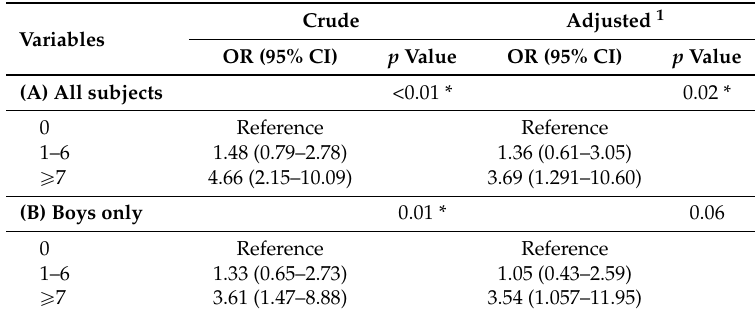
1 Adjusted covariates: gender, consumption of milk/meat/fruit/vegetables, family history of nervous system diseases, parental education levels, maternal alcohol consumption during pregnancy, gene polymorphism of DRD4 at rs752306; * p <